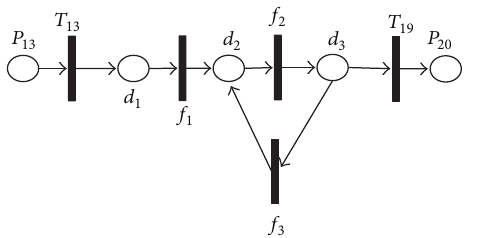
Figure 13: Simplified model graph of optimized matching process Petri